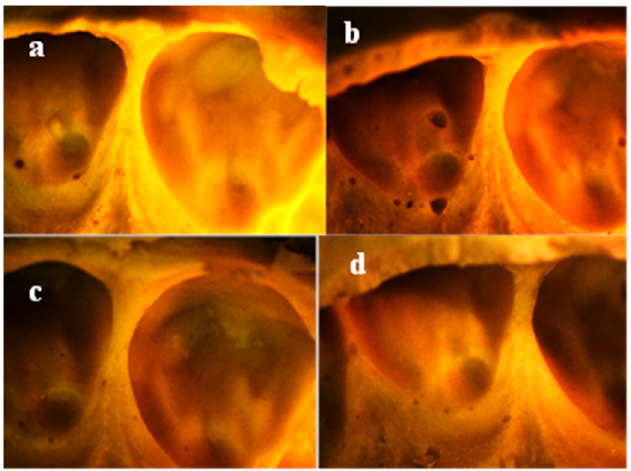
Figure 7. Stereomicroscopic images of clinical impression for patient with open contact, magnification 10 × : ( a ) Group 1 (Algistar mixed as Manufacturer), ( b ) Group 2 (Algistar with ↑ Powder/water ratio, ( c ) Group 3 (Tropicalgin with ↓ Powder/water ratio), ( d ) Group 4 (Tropicalgin mixed as